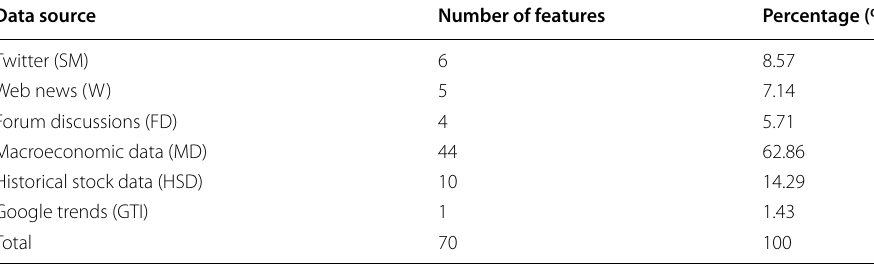
Table 2 Breakdown of fused features Data